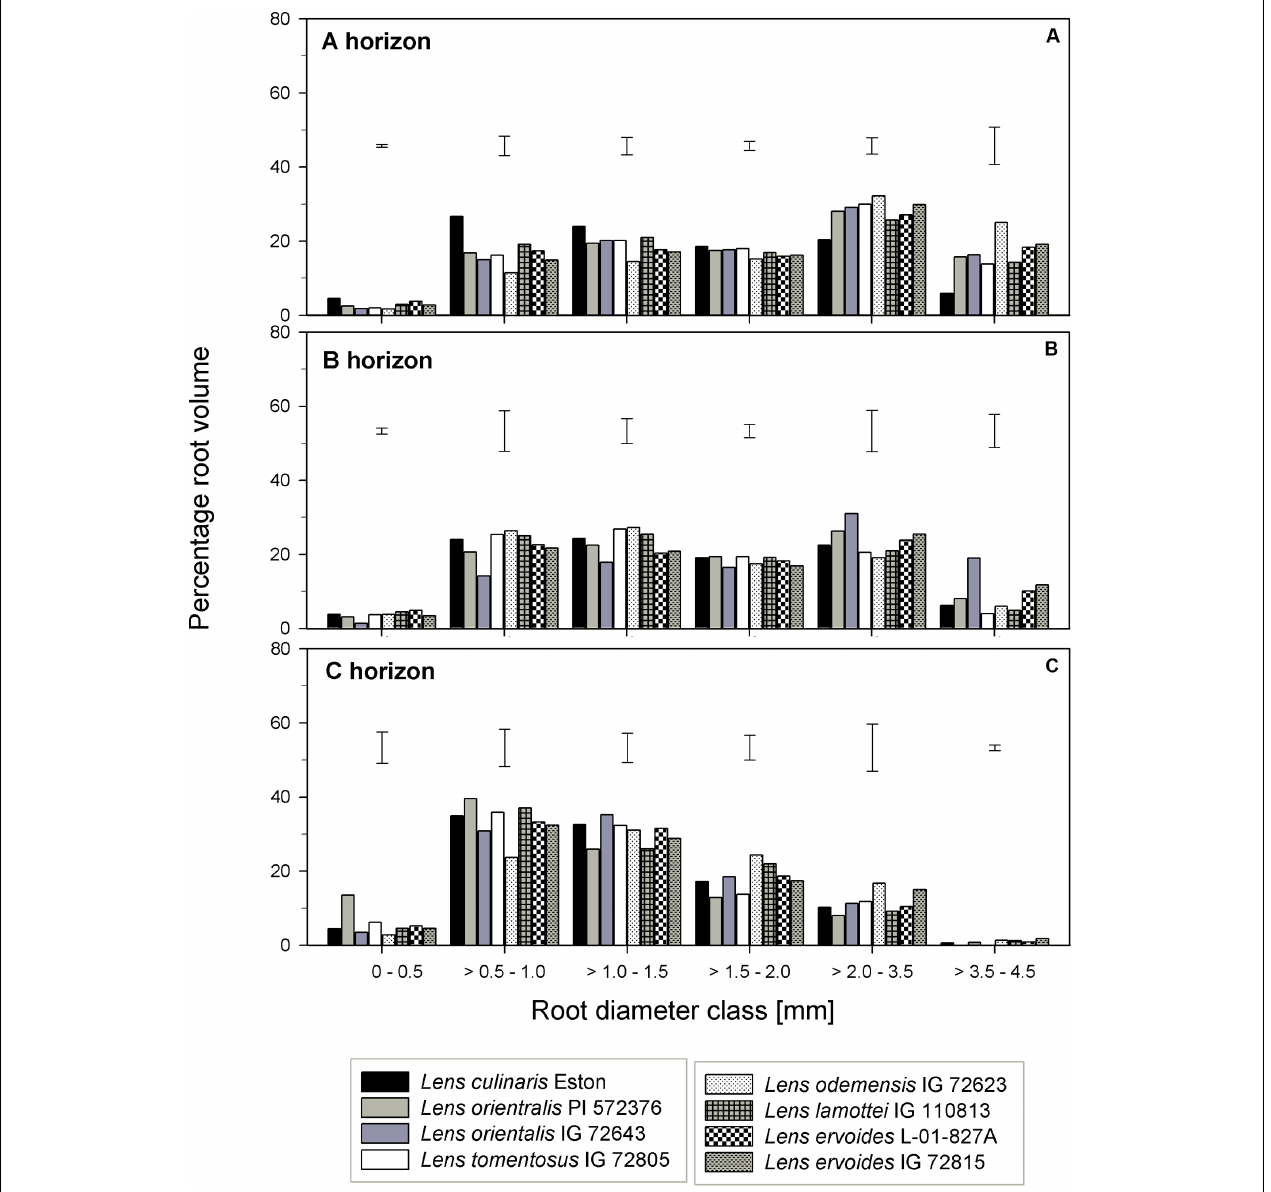
FIGURE 6 | Root volume distribution across six diameter classes assessed in three soil horizons in five wild lentil genotypes in comparison with cultivated lentil ( Lens culinaris Eston). The line bars represent LSD at P < 0.05 for comparison within a given root diameter class. (A) A horizon; (B) B horizon; (C) C